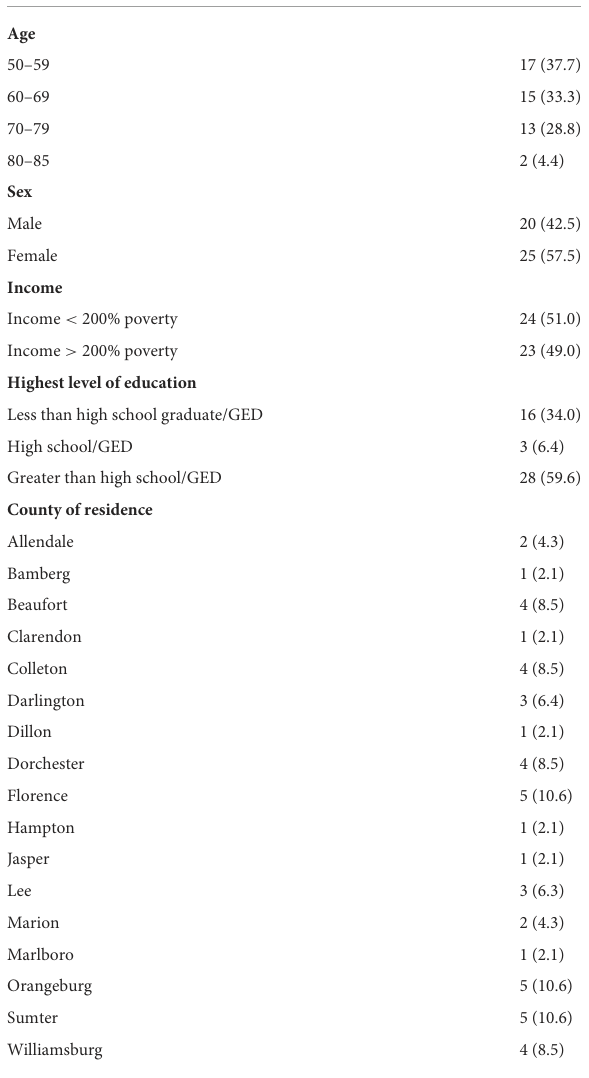
TABLE 1 Demographic characteristics of the sample ( N =